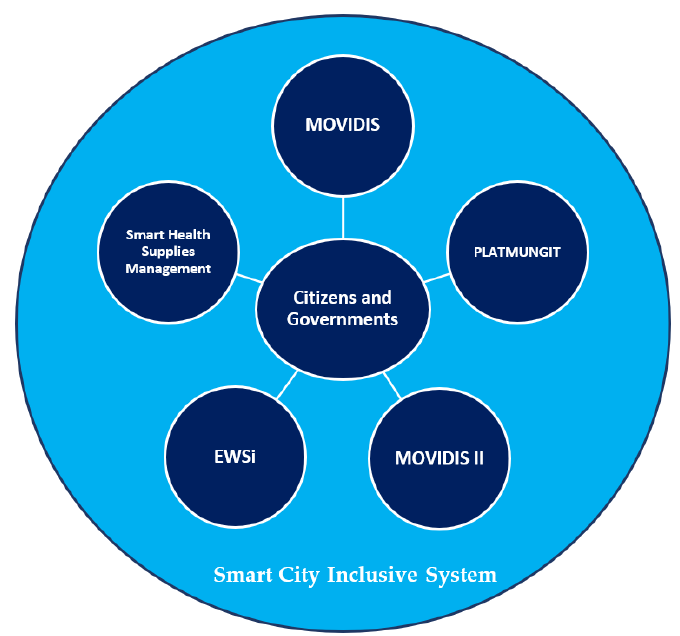
Figure 10. Smart City Inclusion System based on RRD System Modelling.